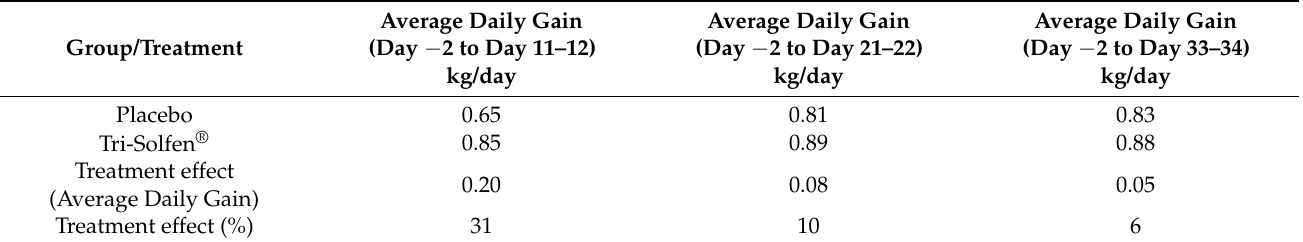
Table 5. Average daily gain (kg/day) in calves from each treatment group over time for Study